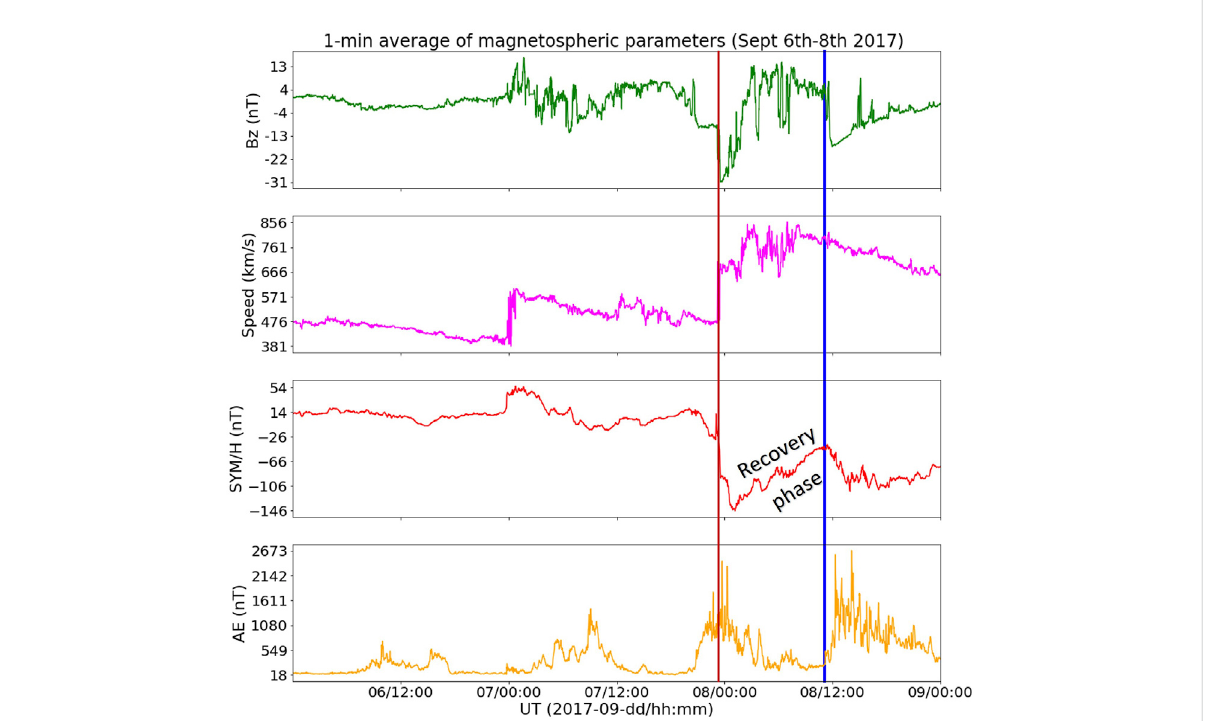
FIGURE 1 Near-earthsolarwindparametersandgeomagneticactivityindicesduringtheextendeddisturbedperiodfrom2017-09-06/00UTto2017-09- 09/00UTfollowingthelargesolarX-ray (classX9.3) fl are of6September2017. Panels (A) , (B) , (C) ,and (D) show themagnetic fi eld fl uctuations,solar wind speed, SYM-H index, and AE index respectively. The vertical blue line marks the time when the strong pitch angle anisotropy of thermal and suprathermal protons was observed. The vertical red line marks the time of the fi rst